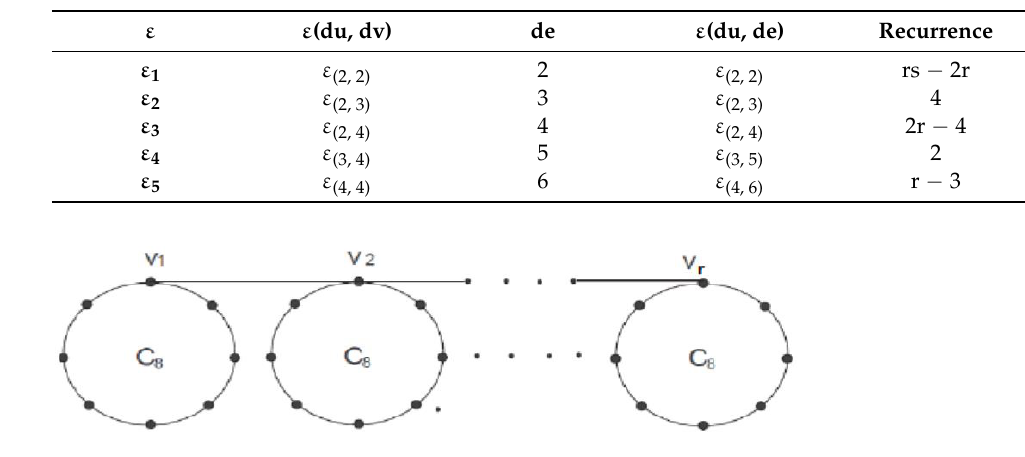
Table 3. Edge partition of G r (K s, v ) over K s .